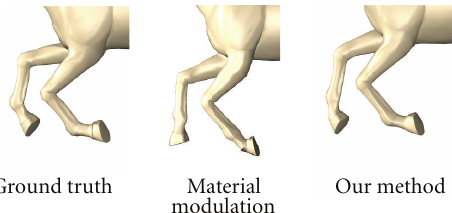
Figure 13: Comparison with the material modulation method [17].